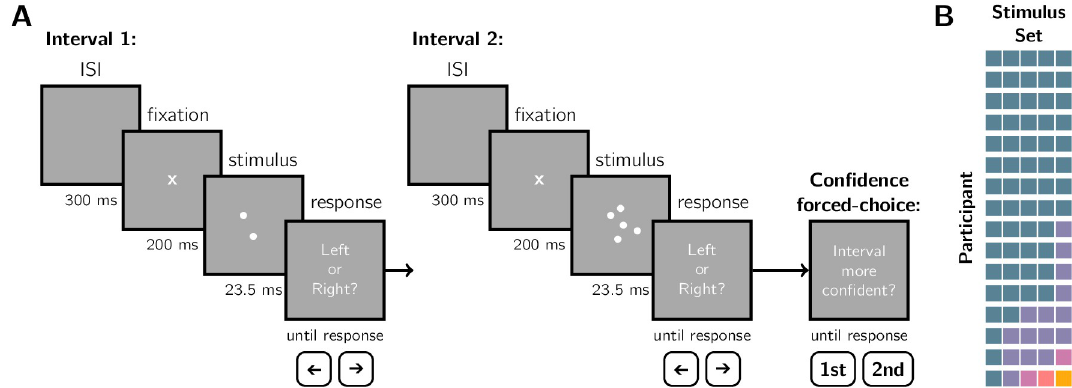
Fig 2. Experimental methods. A) Task design. Observers were shown dots drawn from a Gaussian generating distribution with seven possible horizontal spatial offsets between ± 4˚ from the screen centre. They judged if the distribution mean was left or right of centre. After each pair of perceptual decisions (Interval 1 and Interval 2), they reported the interval in which they had higher confidence in their decision. There were six levels of stimulus uncertainty, defined by information quantity (number of dots: 2 or 5) and quality (sampling distribution SD: 1.5, 2, or 2.5˚), presented in an interleaved design. B) Occurrence of unique stimulus sets (colour coded). Squares: stimulus set in a single session. Sets are ordered by type, not session order, and participants by frequency of stimulus set repeats (5-pass to